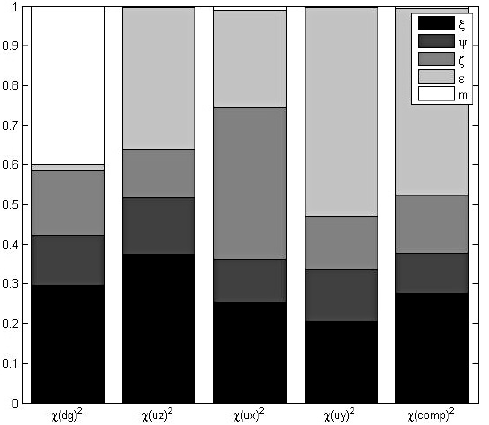
Fig. 7. Normalized E-FAST Total Sensitivity Indices (TSI) for the five defined output parameters (one run consisting of 28645 sam- ples).